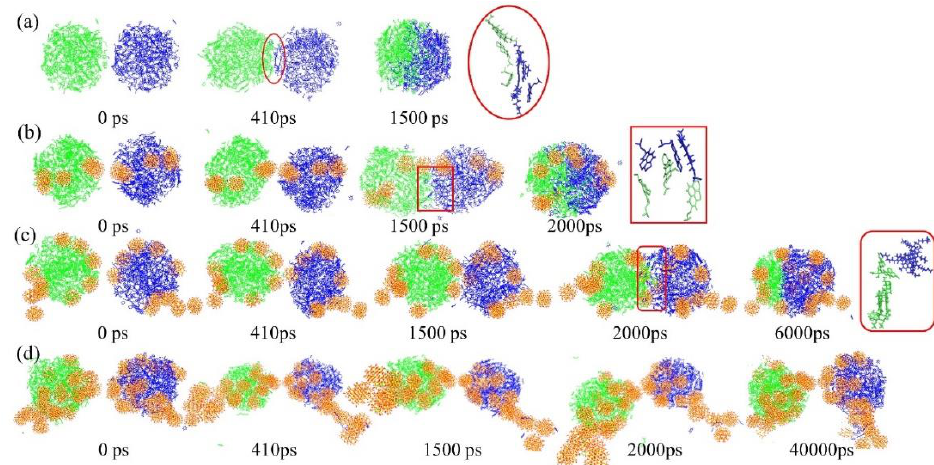
Figure 8. Snapshots of droplet coalescence. In order to distinguish the two droplet components, the two droplet components are represented by green and blue linear models. The coalescence behavior of oil droplets in System C-I ( a ). The coalescence behavior of oil droplets in System C-II ( b ). The coalescence behavior of oil droplets in System C-III ( c ). The coalescence behavior of oil droplets in System C-IV ( d ).